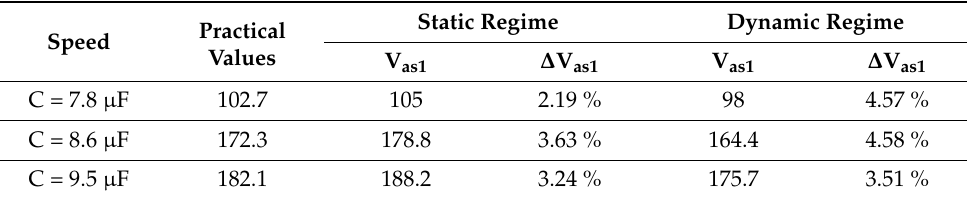
Table 5. Static and dynamic results under load with N = 1500 rpm and variable